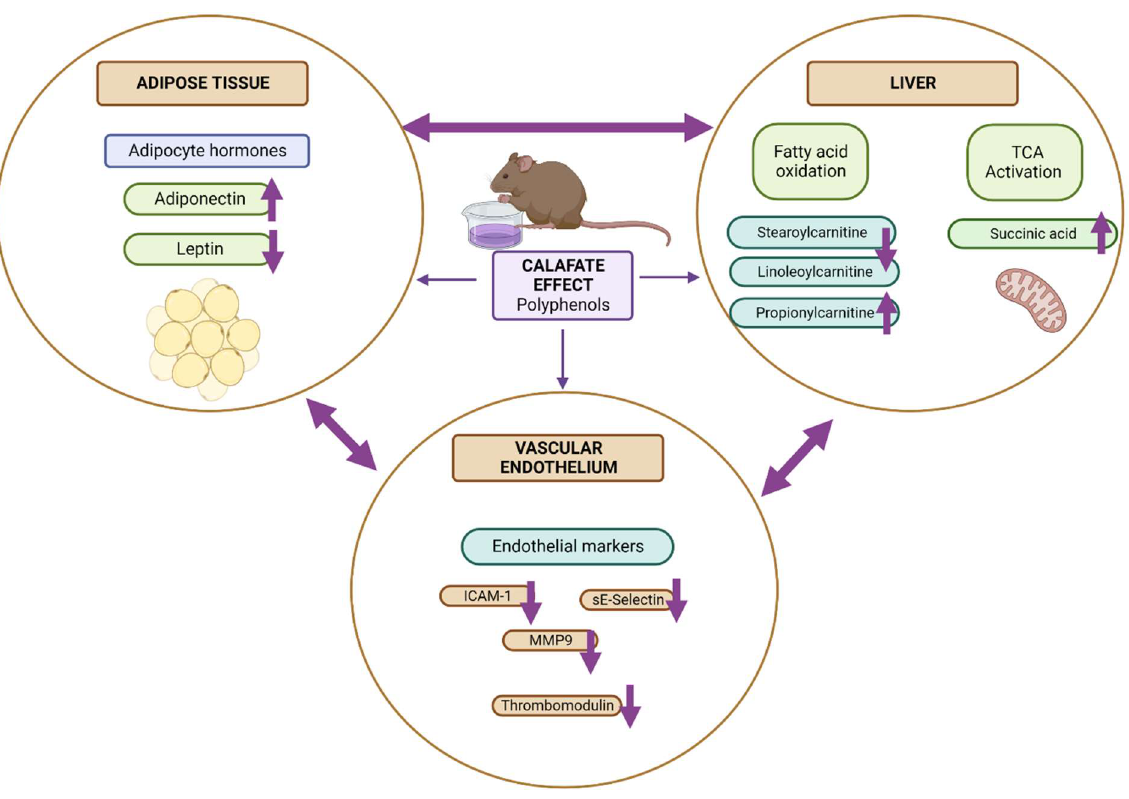
Figure 5. Proposal of the systemic effect caused by Berberis microphylla G. Forst (calafate) berries.